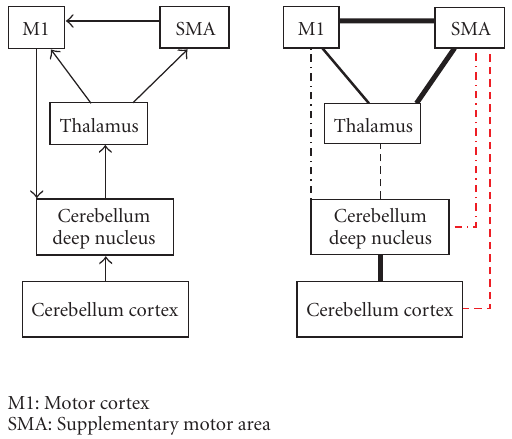
Figure 8: The network and results for White et